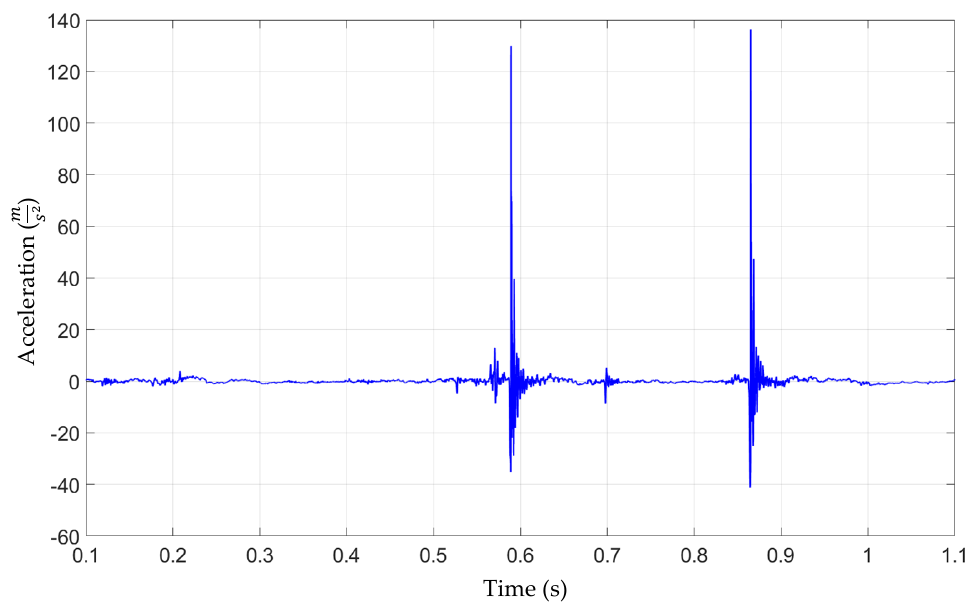
Figure 10. Electric Power Steering (Nominal Production)–Acceleration signal at CRB, 500 N preload, no grease at the rack–pinion and CRB interface.